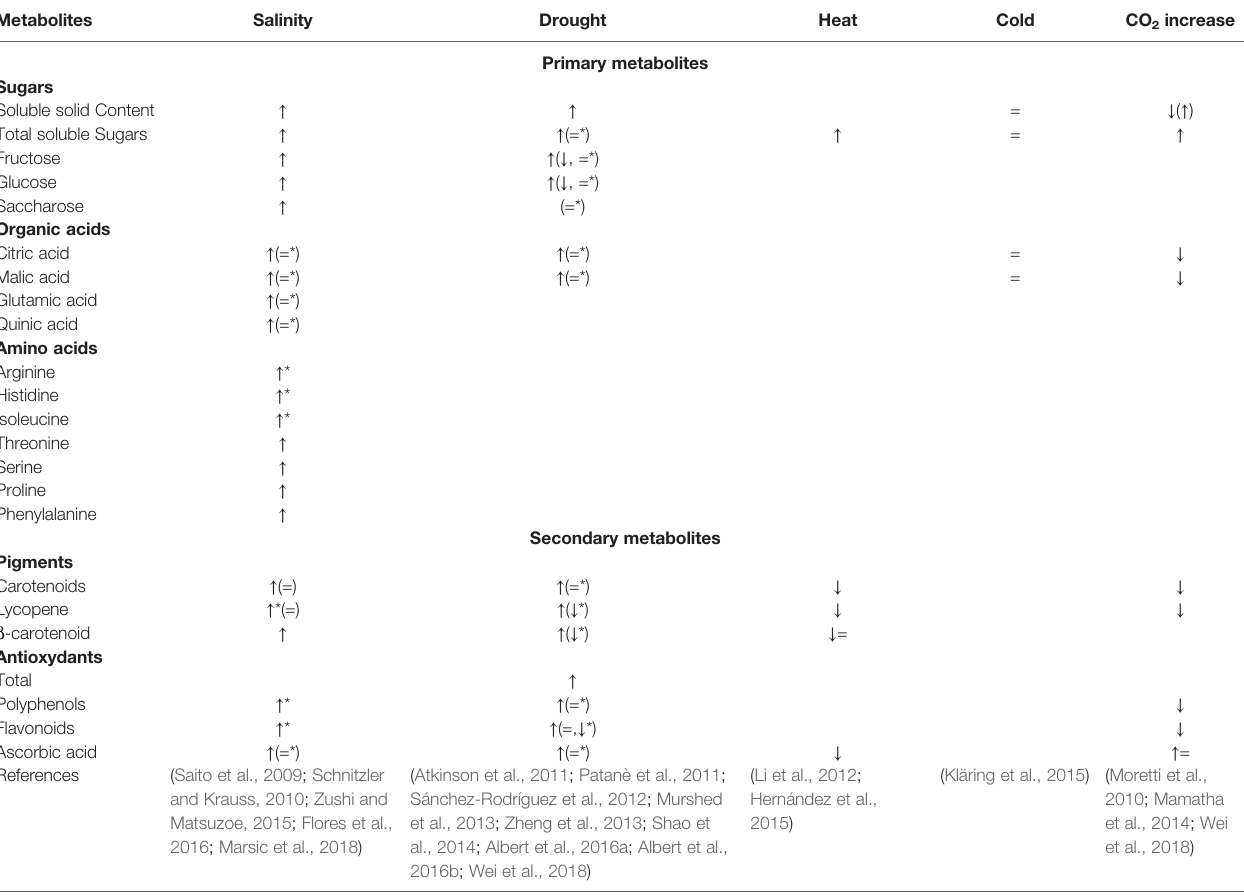
TABLE 1 | Effect of abiotic stress occurring during plant growth on primary and secondary metabolite production in tomato fruits.